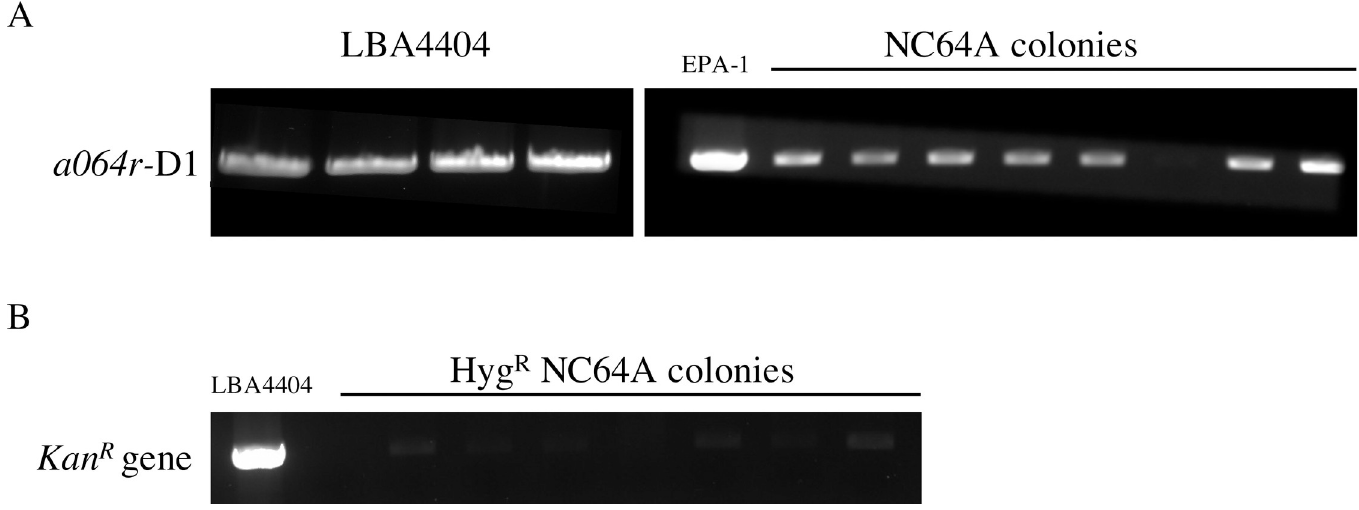
Fig 2. PCR analysis of putative NC64A transformants transformed with recombinant pCAMBIA1304 034r domain 1. (A) Amplification of the 633 bp fragment of the a064r domain 1 gene fragment from four LBA4404 colonies post-electroporation, and eight NC64A colonies after Agrobacterium -mediated transformation. (B) Amplification of the Kan R gene from LBA4404 (positive control) but not in the seven putative NC64A transgenic lines.